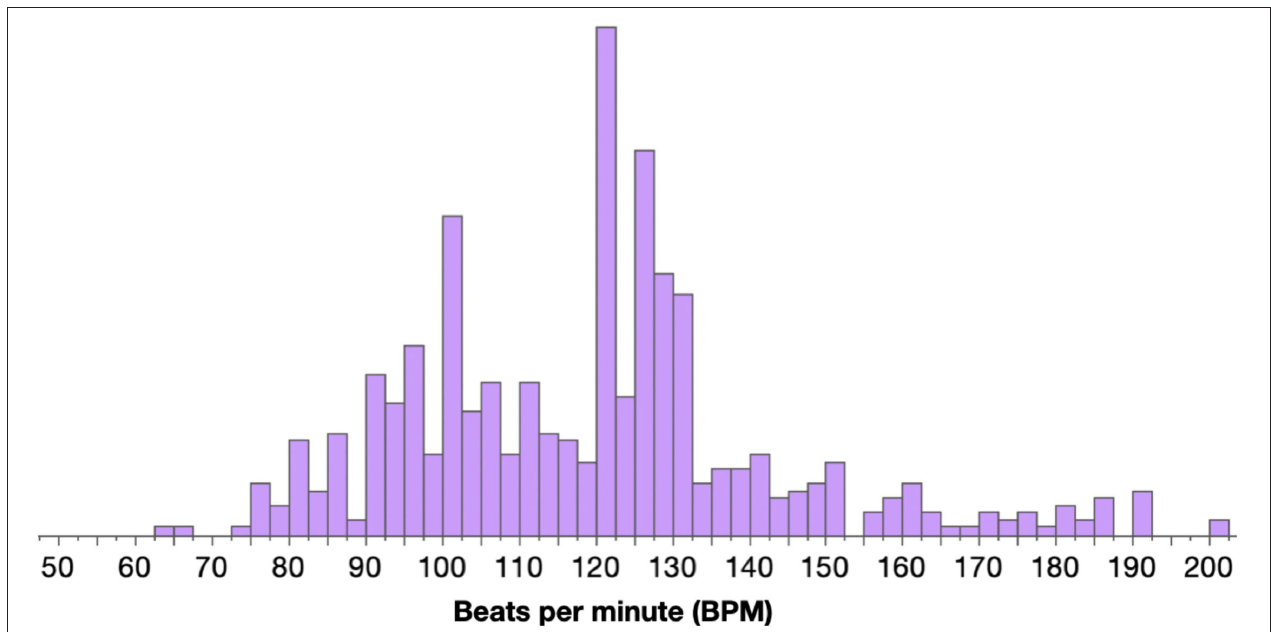
FIGURE 2 | The above histogram is compiled from a Kaggle dataset containing the “Top 50” Billboard songs from 2010 to 2019. It appears to be a resonance curve showing maximum excitement at a preferred frequency of oscillation. However, note the sharp dropoff from 120 BPM to 118 BPM—this is not expected in a resonance curve, as the frequencies close to resonance tend to resonate strongly as well. There may simply be very few songs released with this BPM. But, while this graph might not be a resonance curve, it may be a result of meaningful resonance effects in the brain—an increase in amplitude due to the alignment of external frequencies with natural frequencies https://www.kaggle.com/leonardopena/top-spotify-songs-from-20102019-by-year.